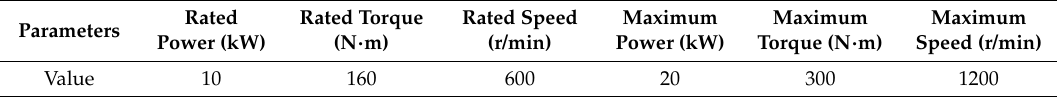
Table 4. Steering motor parameters.